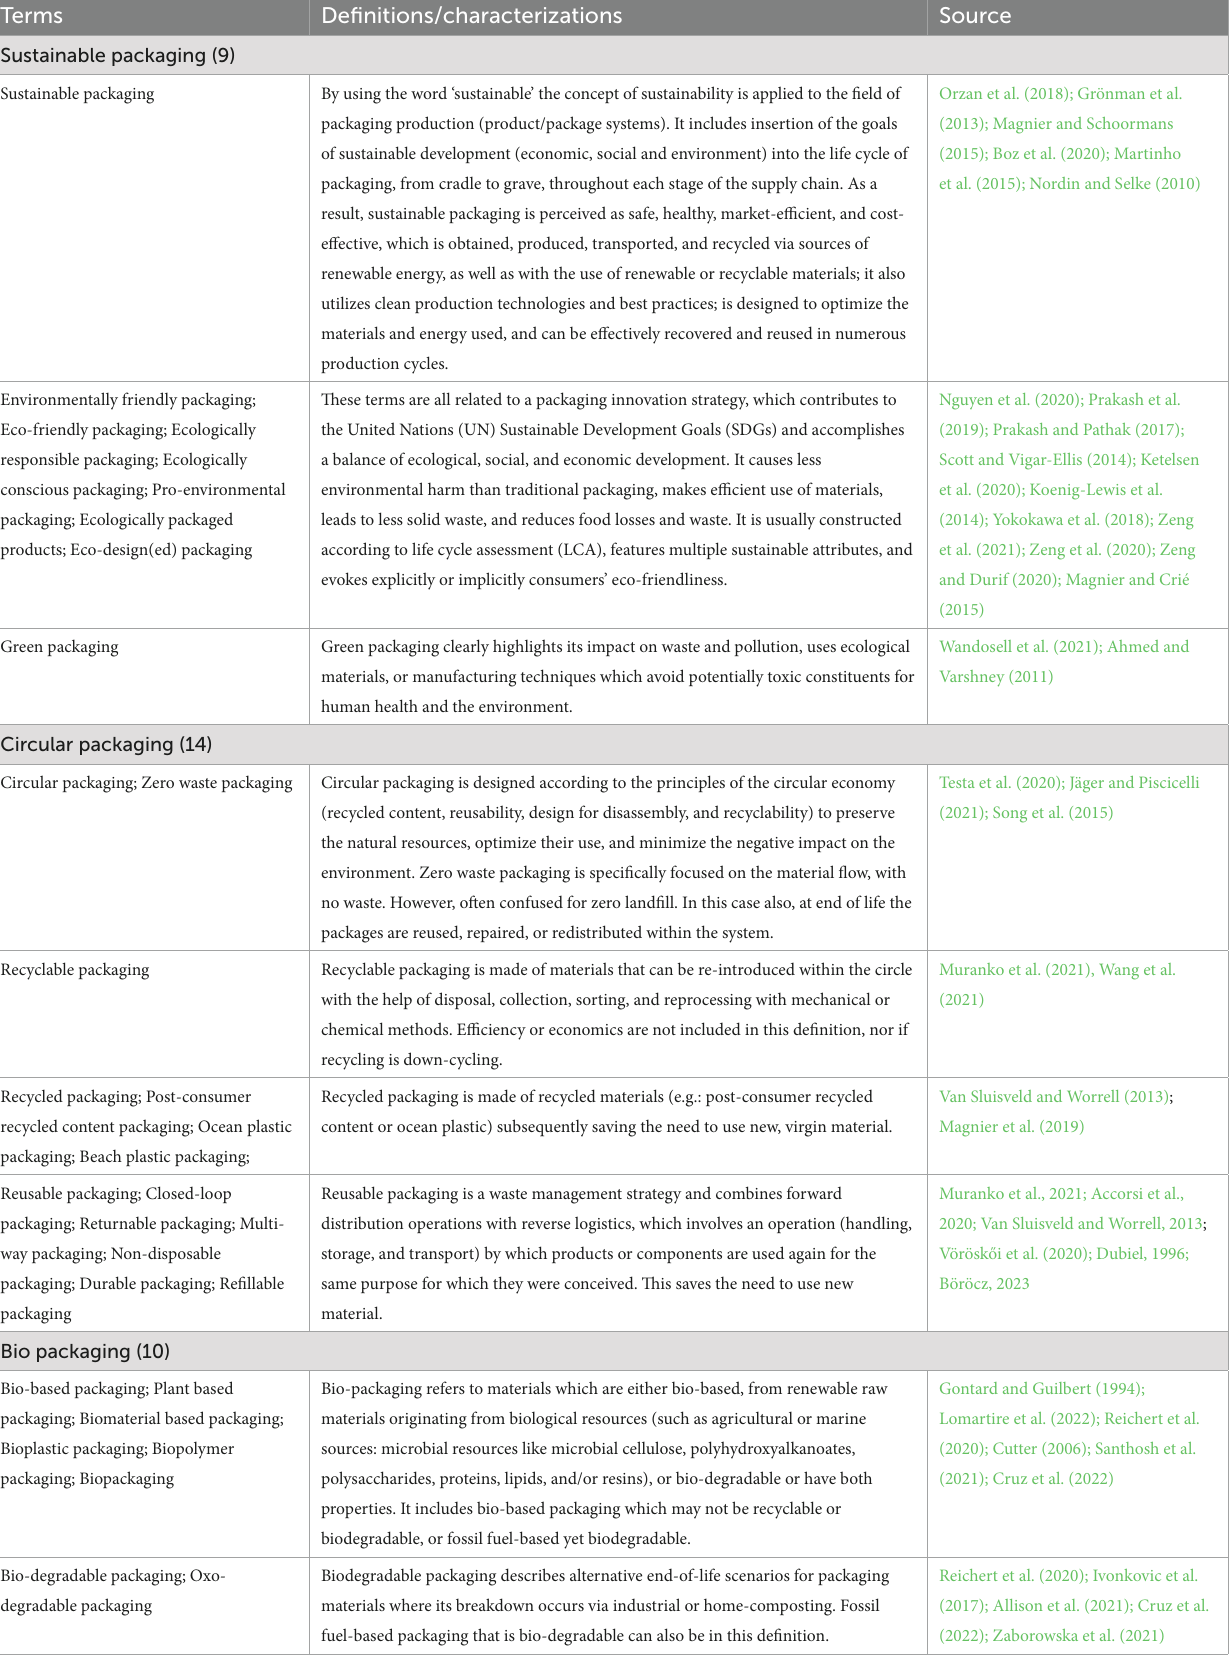
TABLE 1 Review of terminology used for sustainable packaging